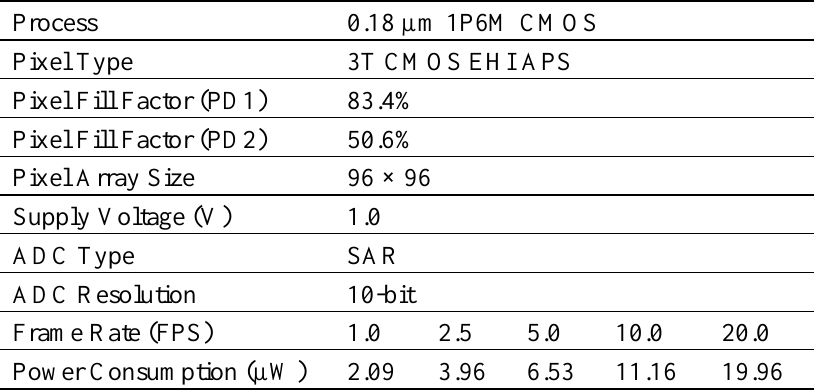
Table 1. Performance summary of the EHI imager.